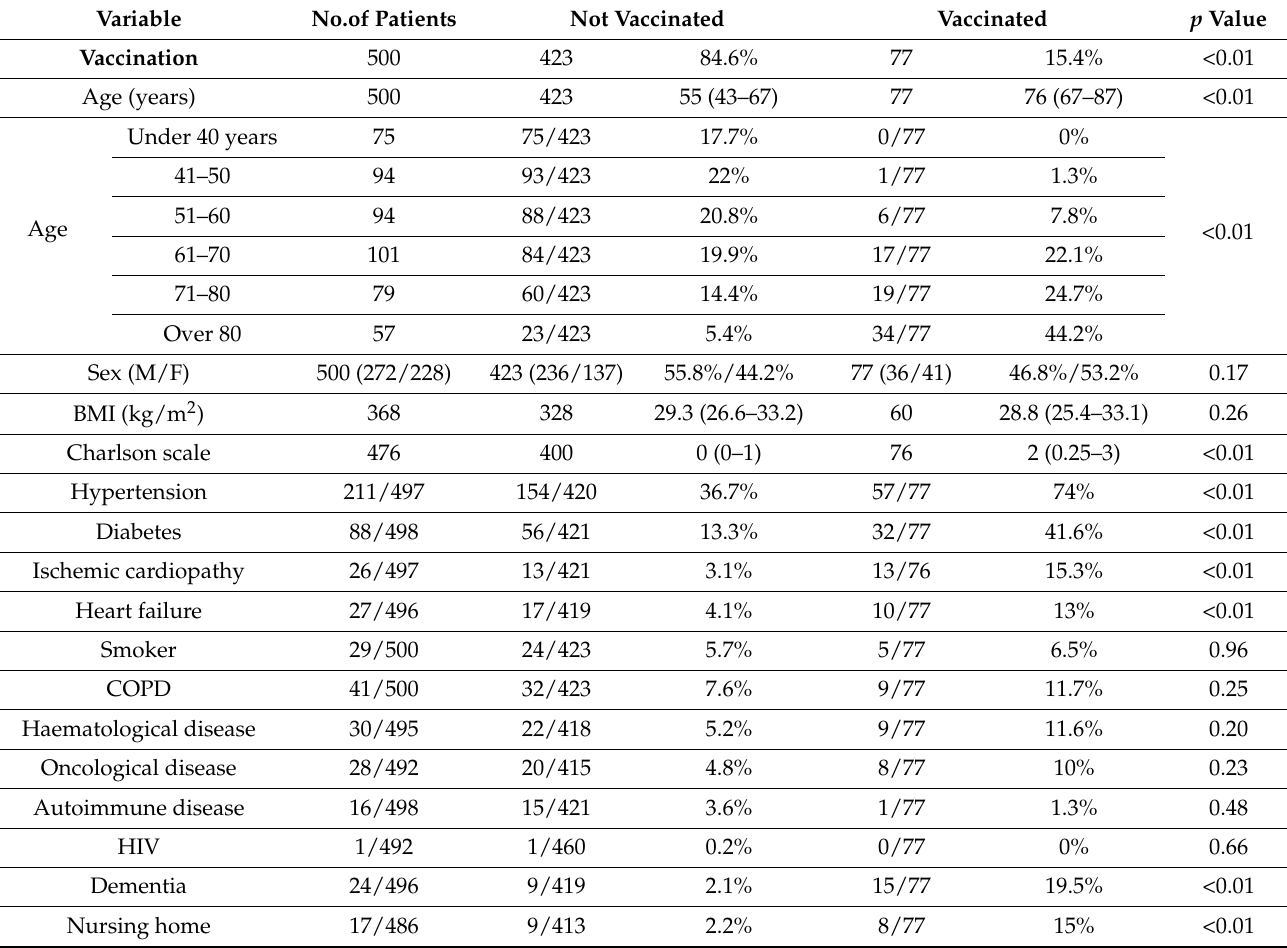
Table 2. Demographic and comorbidities related to the not vaccinated and vaccinated cohorts